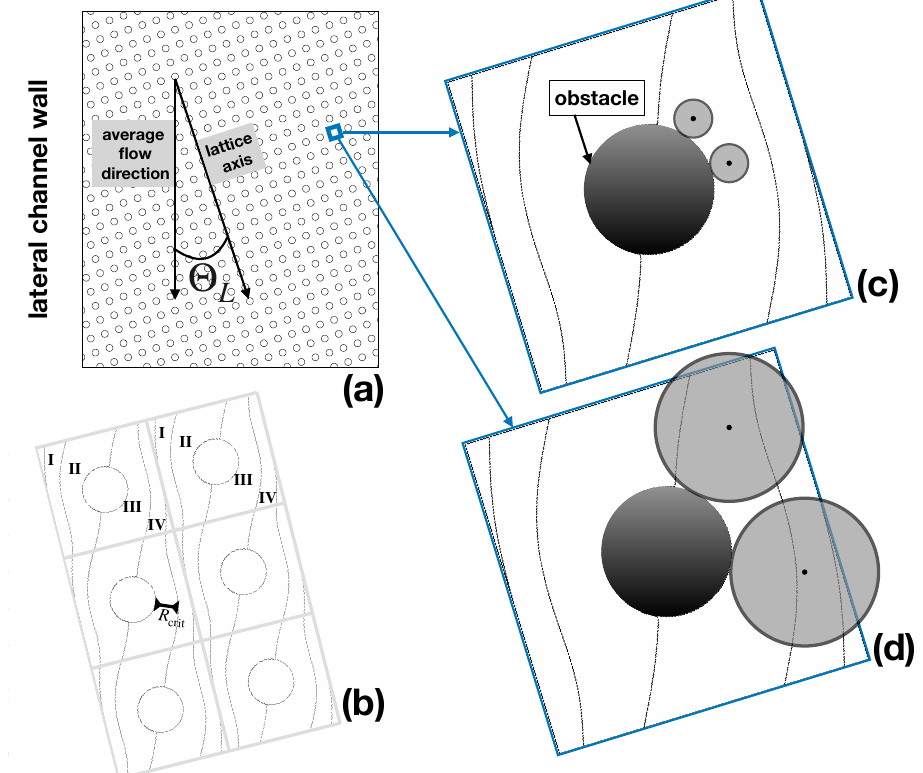
Figure 1. Kinematic model of particle transport. ( a ) lattice geometry; ( b ) critical streamlines defining the lanes (fluxtubes) stemming from the solution of the pressure-driven Stokes flow through the periodic lattice; ( c ) subcritical particle; ( d ) supercritical particle. The particles have been superimposed in their relative scale with respect to the unit periodic cell to the flow